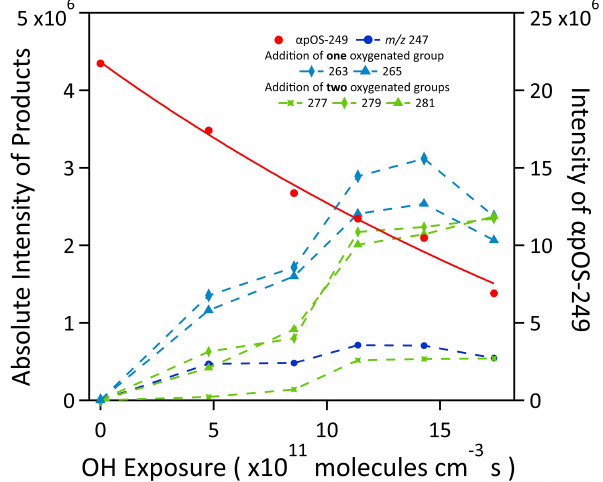
Figure 4. The evolution in the signal intensity of the reaction prod- ucts formed upon the heterogeneous OH oxidation of α pOS-249 as a function of OH